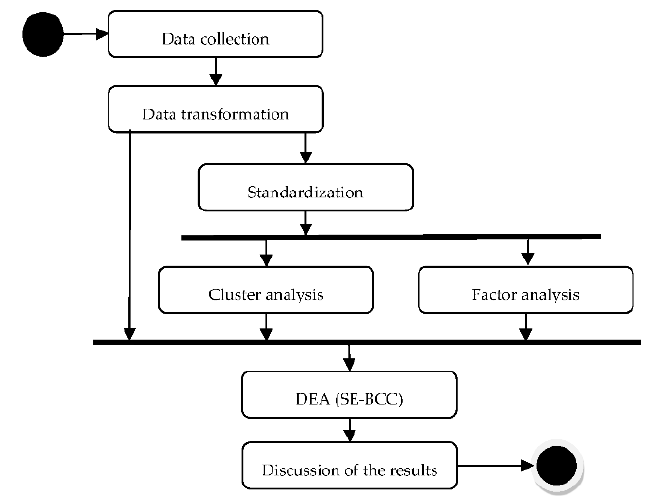
Figure 2. Research